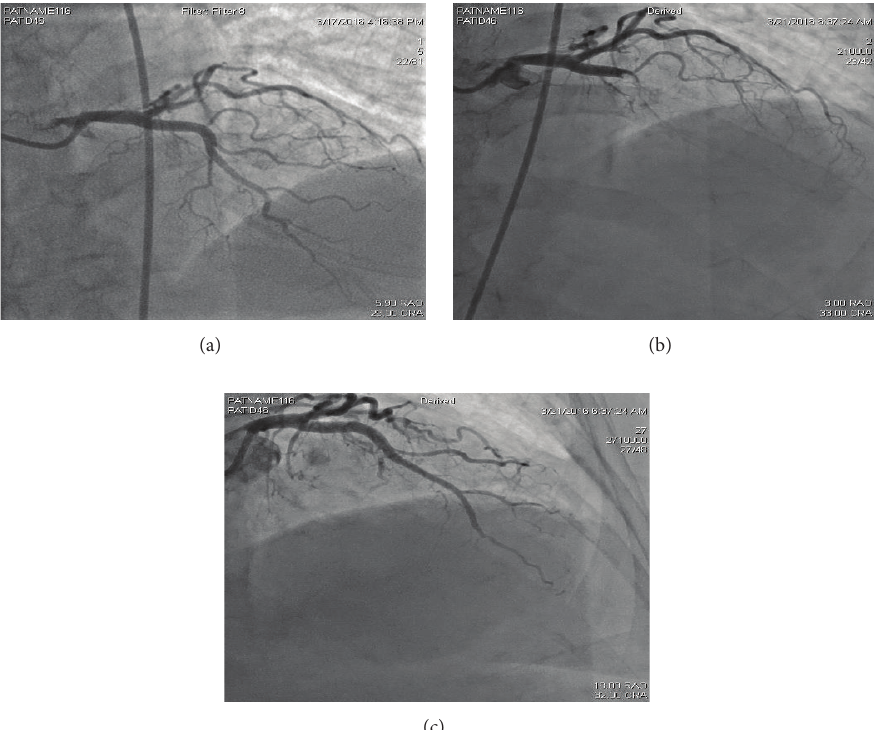
Figure 2: (a) First left heart catheterization showing LAD with minor luminal irregularities. (b) Second left heart catheterization (4 days later) showing the mid-LAD lesion. (c) LAD after